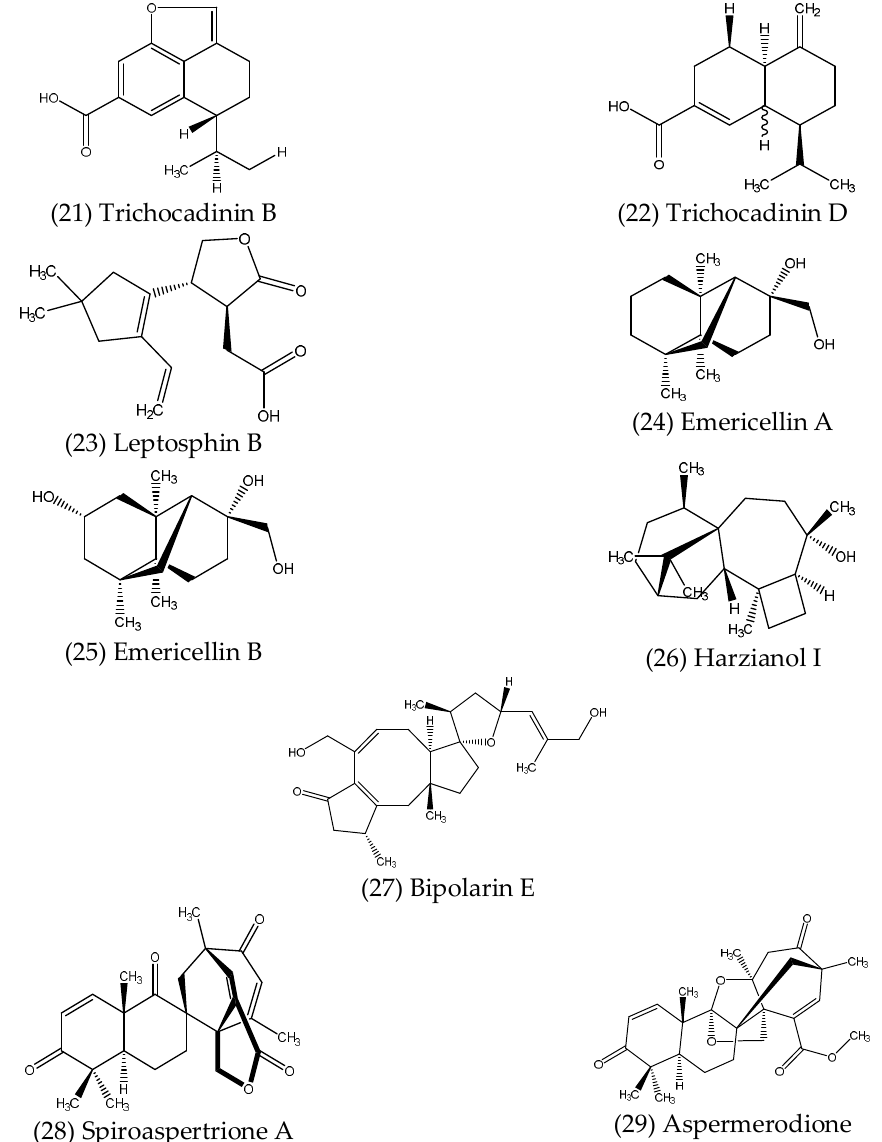
Figure 6. Structures of antimicrobial terpenoids produced by endophytes. Table 2. List of newly discovered antimicrobial compounds isolated from endophytic fungi.